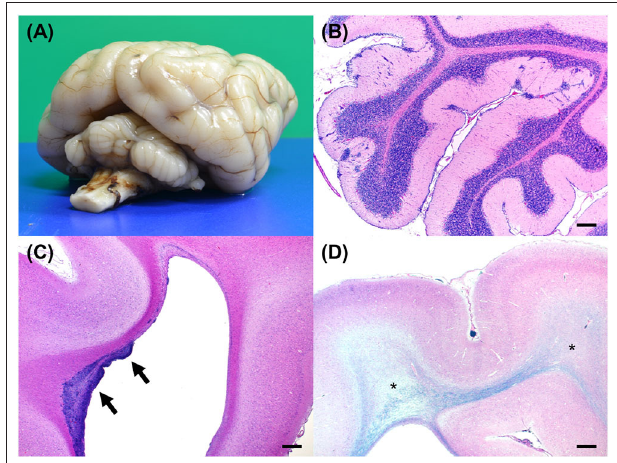
FIGURE 4 | Gross and histopathological necropsy findings. (A) A diagonal view of the fixed brain shows hypoplasia of the cerebellum. The cerebellar vermis is markedly small. (B) An HE-stained section of the cerebellum shows clusters of ectopic cells in the cerebellar cortex. Bar = 500 µ m. (C) An HE-stained section of the cerebrum shows clusters of cells in the wall of lateral ventricle in the frontal lobe (arrows). Bar = 500 µ m. (D) Luxol fast blue and HE-stained section of the cerebrum shows rarefaction of the white matter with hypomyelination (asterisks). Bar = 500 µ m.